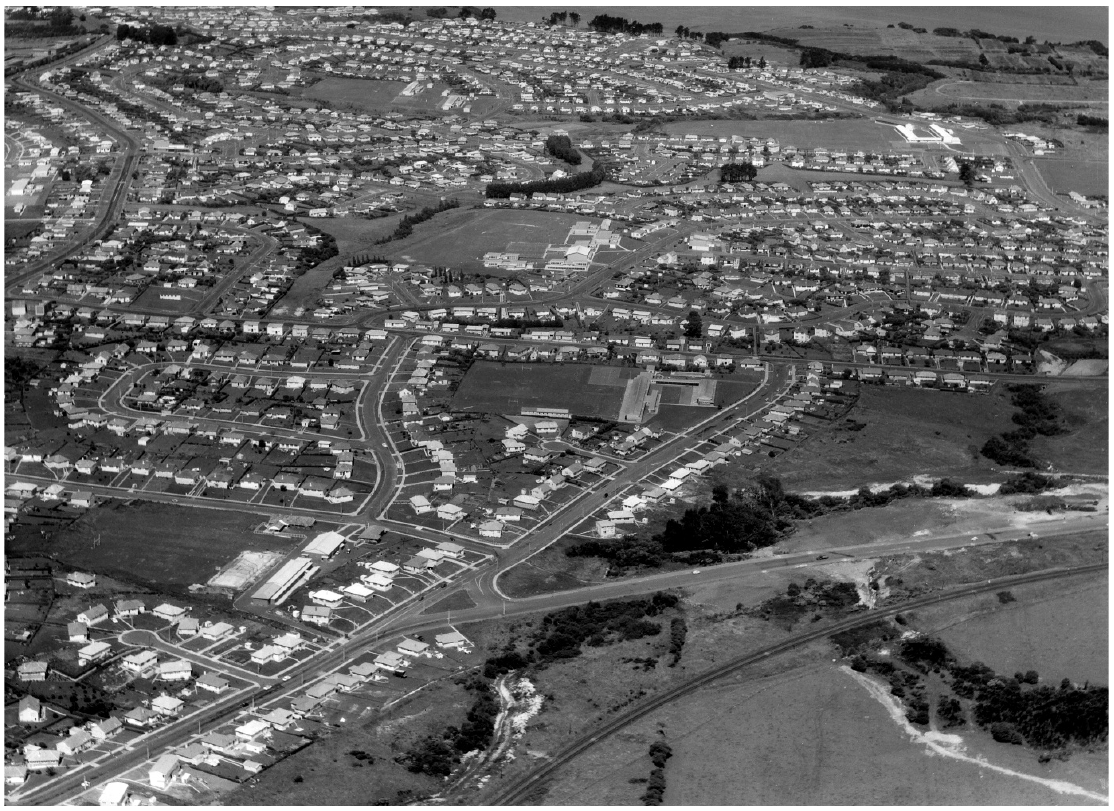
Figure 1. Glen Innes, Auckland, 12 December 1961. Whites Aviation Ltd.: Photographs. Aerial photograph of the northern part of the Tamaki state house scheme. The pilot project house is featured in the bottom left side of the image. Source: Alexander Turnbull Library, Wellington, New Zealand. Ref: WA-56411-F.